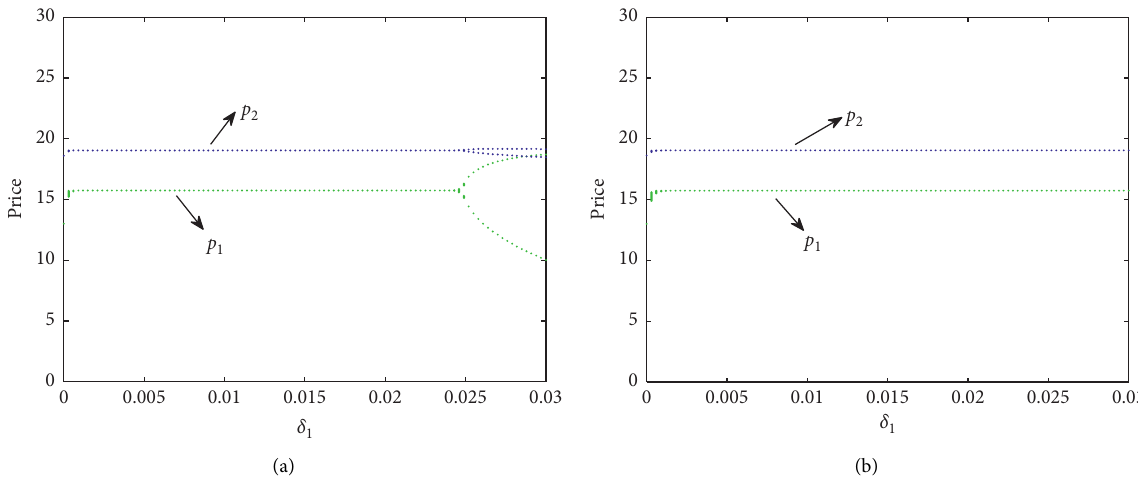
Figure 16: The bifurcation diagram of controlled system (19) with δ